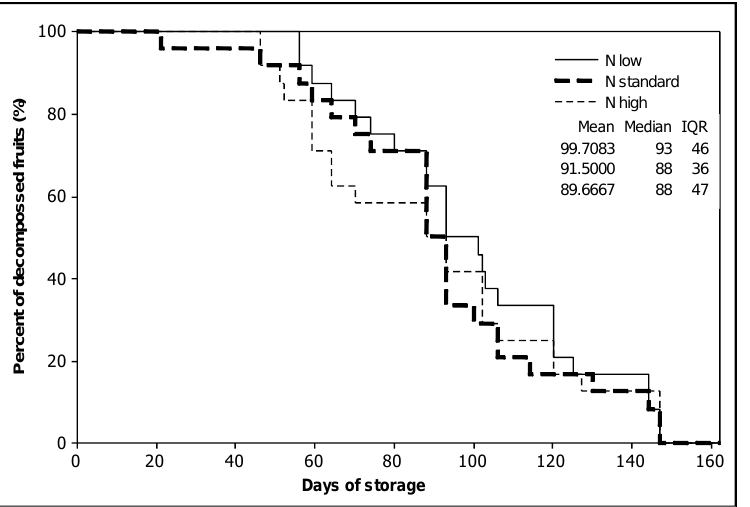
Figure 3. Survival plot for the effect of the nitrogen treatments on the number of days of storage at room temperature until tomato fruits began to show signs of rotting (the test was terminated at 147 days).